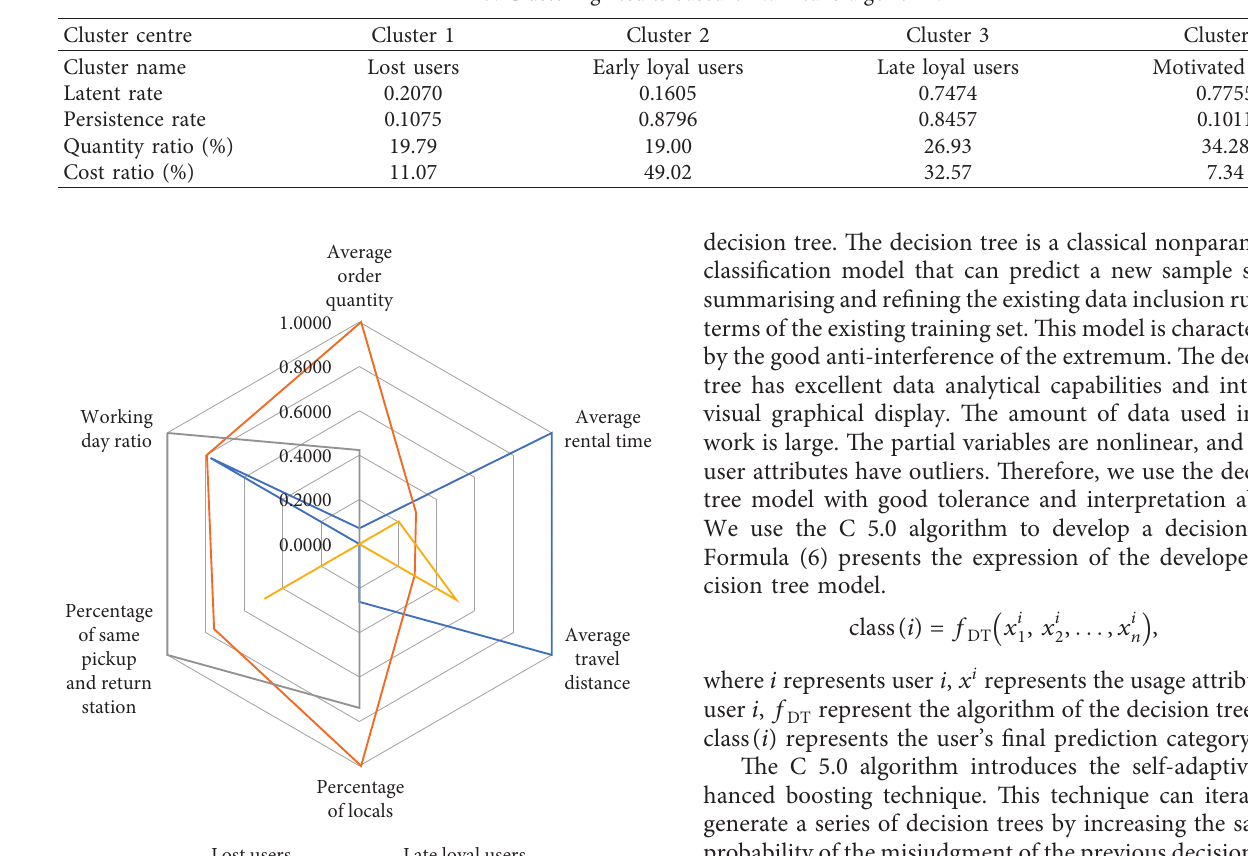
Table 5: Clustering results based on k -means